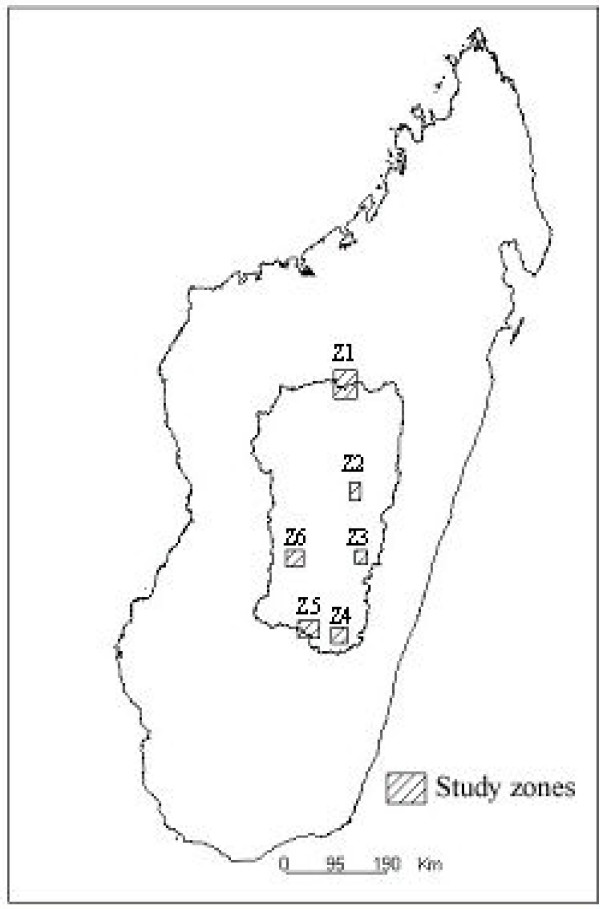
Geographical location of the study zones in the central highlands of Madagascar.